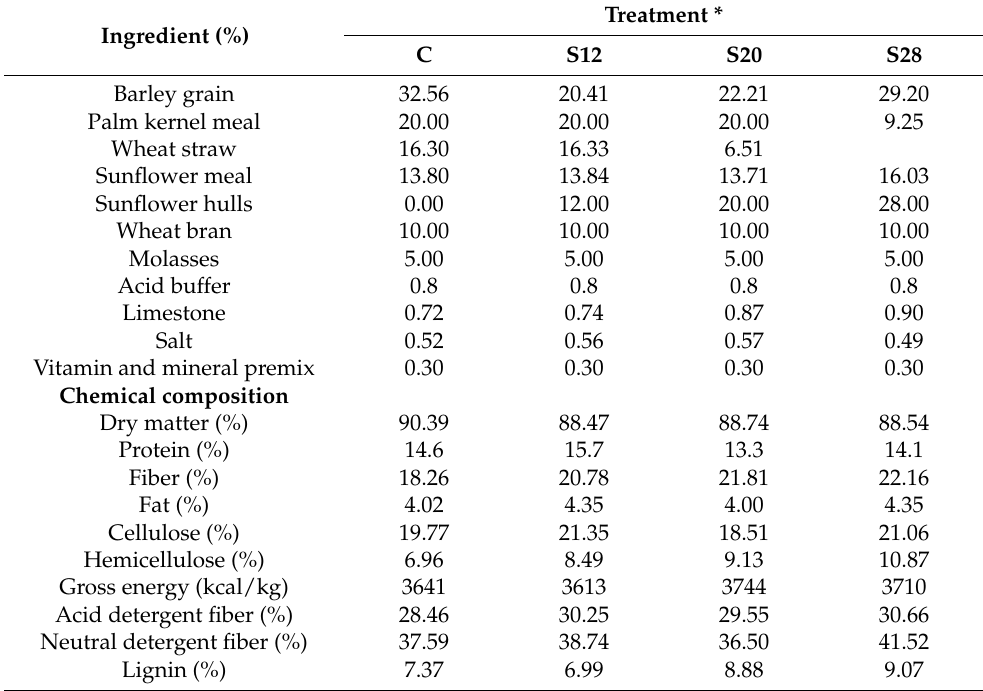
Table 1. Compositions of the experimental diets.